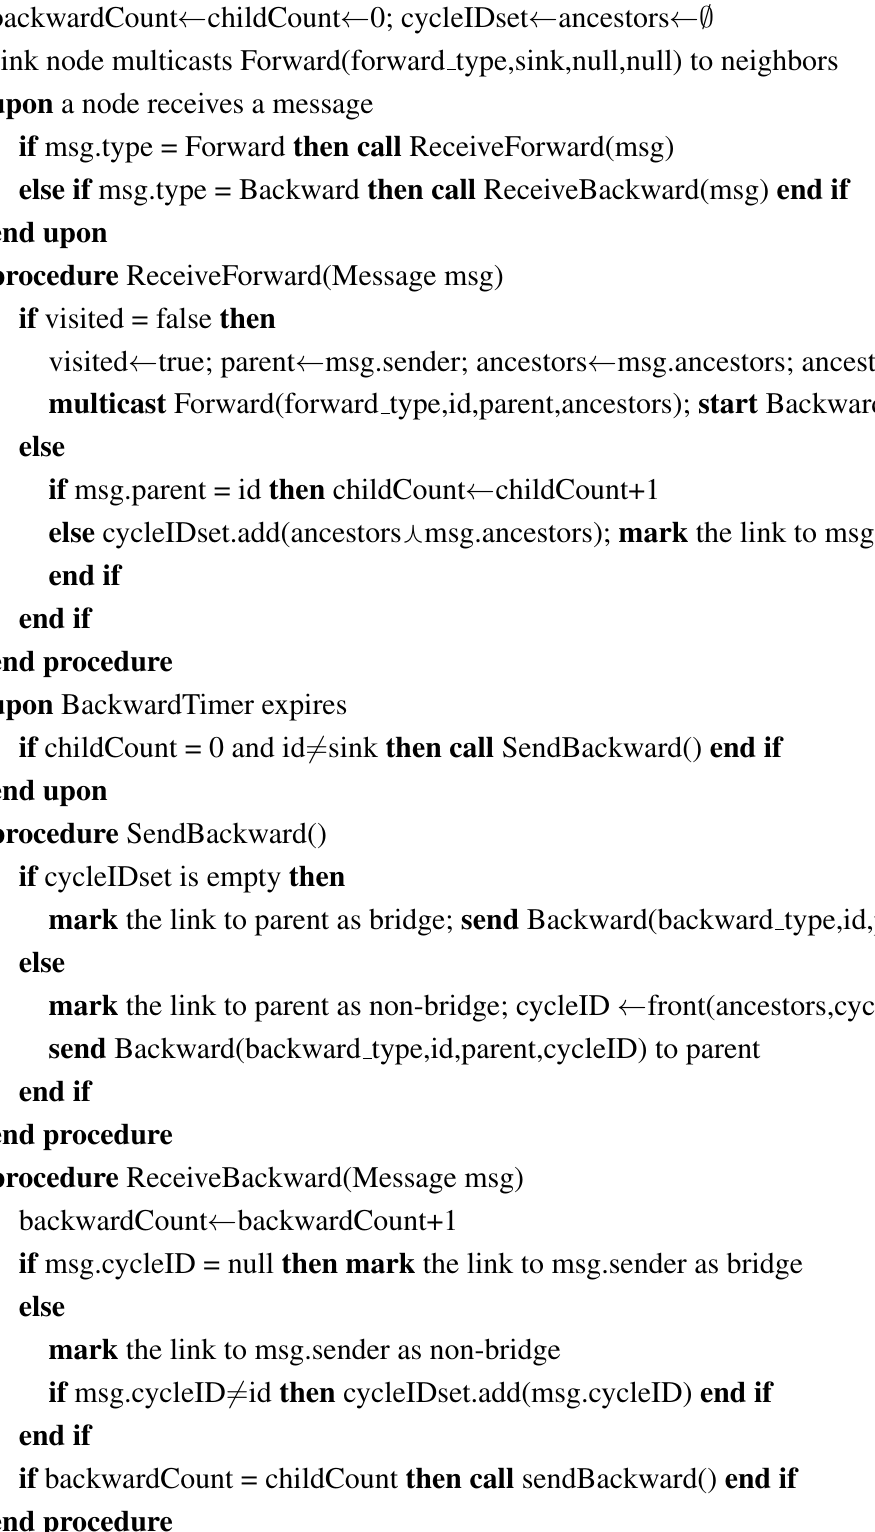
Algorithm 1 ABIDE